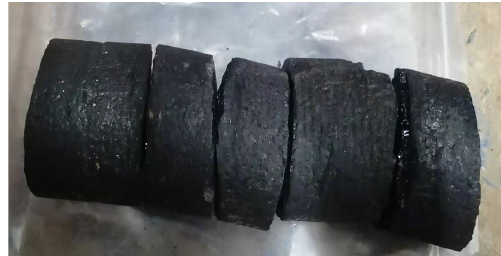
Figure 1. Sample P1 Overview.